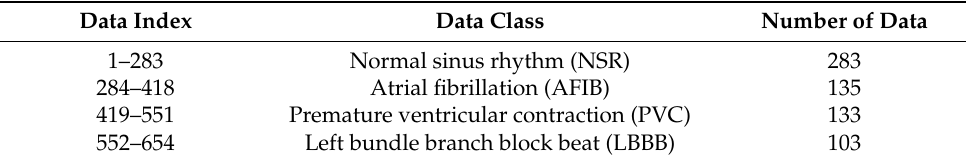
Table 1. Datasets used in this